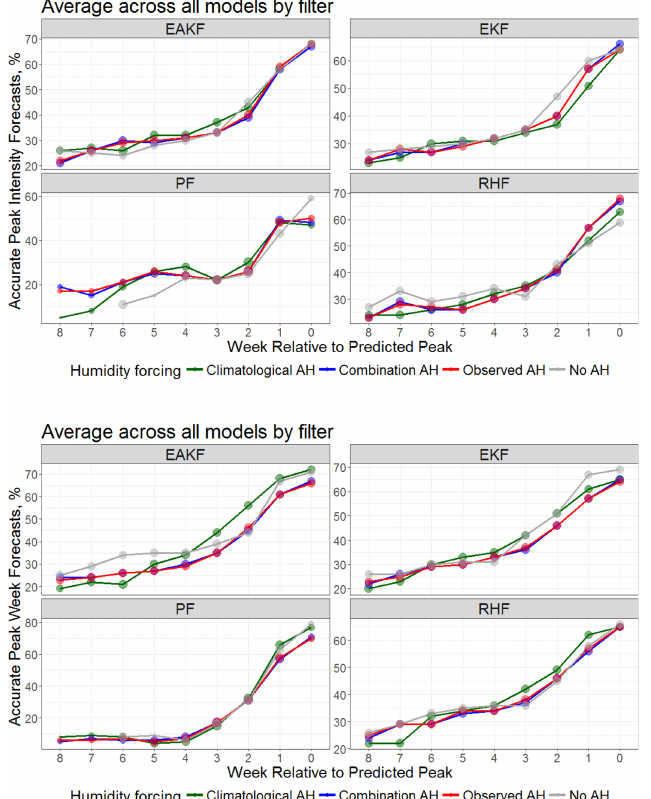
Fig 5. Percentage of forecasts accurate for predictions of peak intensity (top, within ± 25%of observed peak intensity) and peak timing (bottom, within ± 1 week of the observed peak) plotted as a function of forecastlead relative to the predicted peak for each of the 4 filters (EAKF, EnKF, PF and RHF). Shown are the forecast accuraciesfor models with climatological AH forcing (green), observedAH forcing (red), a combination of observedAH duringoptimizationand climatological AH during forecast (blue), and no AH forcing (grey). The number of forecasts (log transformed) at each lead is representedby the size of the